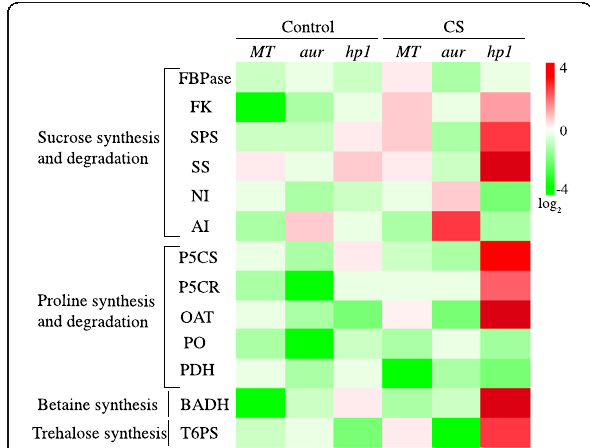
Fig. 7 Heat map of a selected set of enzymes related to the different osmolytes biosynthetic pathways (synthesis and degradation). The enzyme activities were measured in in leaves from wild-type genotype (MT) and aurea ( aur ) and high pigment1 ( hp1 ) mutants of tomato under control and chilling stress (CS) conditions. Red color represents higher relative activity and yellow color represents lower relative activity. Scale is the log 2 of the mean concentration values after normalization ( n = 10). The data is representative of two independent